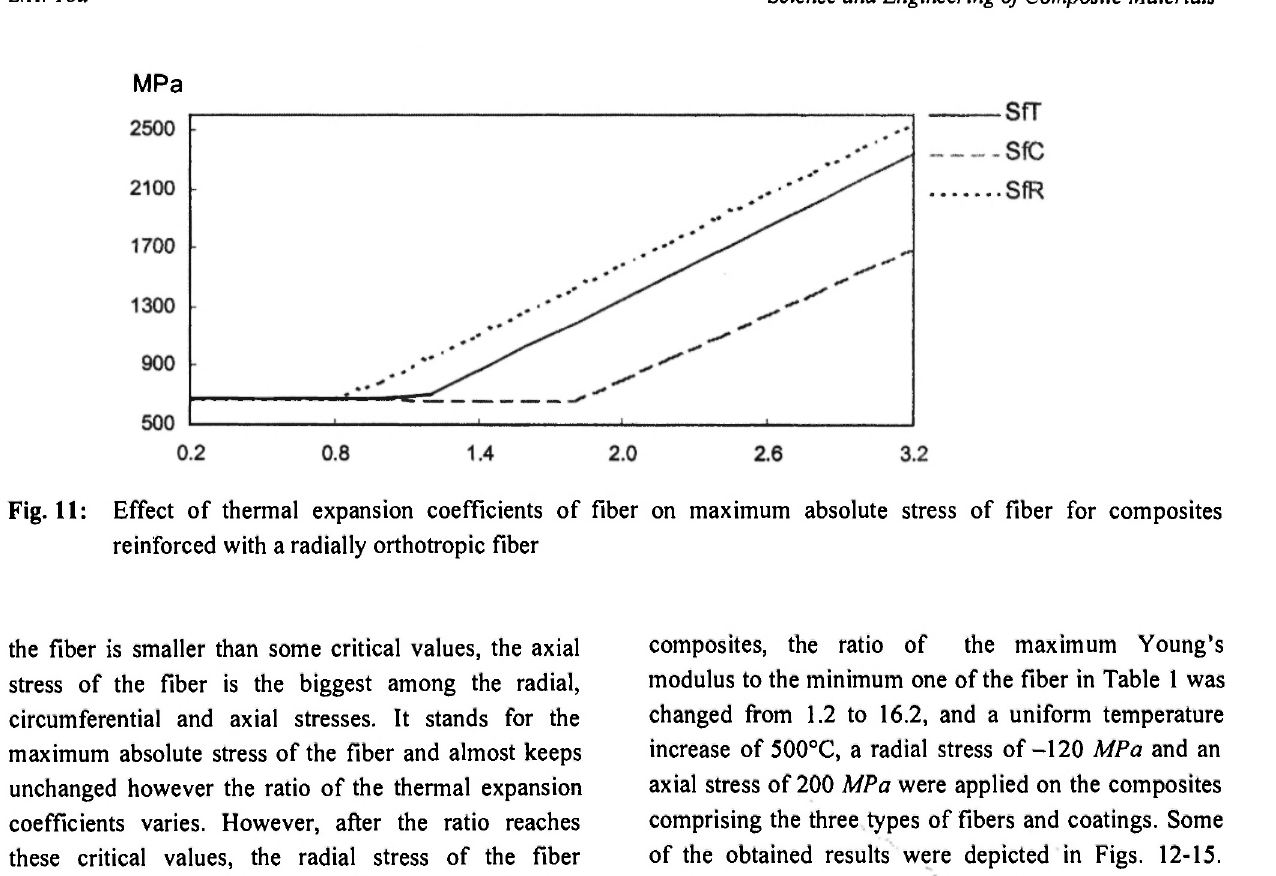
the fiber is smaller than some critical values, the axial stress of the fiber is the biggest among the radial, circumferential and axial stresses. It stands for the maximum absolute stress of the fiber and almost keeps unchanged however the ratio of the thermal expansion coefficients varies. However, after the ratio reaches these critical values, the radial stress of the fiber becomes the largest. It represents the maximum absolute stress and increases quickly when the ratio rises. For different types of the coatings, these critical values are different (Fig. 11). Raising the ratio of the thermal expansion coefficients of the fiber can increase the maximum absolute stress of the coating for the composites comprising a circumferentially orthotropic coating, but slightly decrease it for the composites comprising radially orthotropic coatings (Fig. 8). The influences of the thermal expansion coefficients of the fiber on the of the matrix, for the composites comprising the three types of fibers and coatings are almost the same.